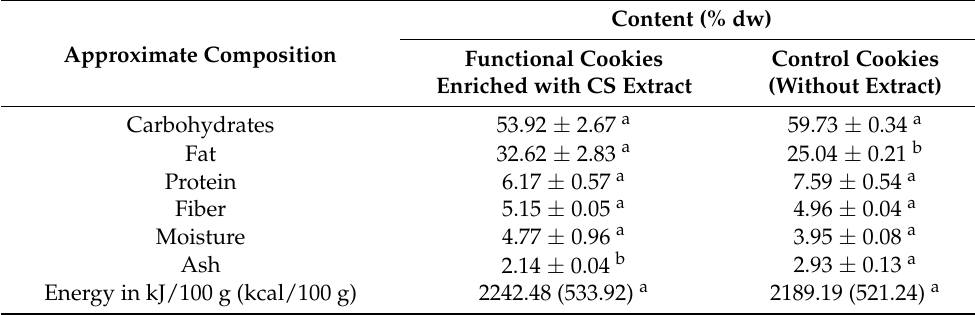
Table 2. Approximate composition (% dw) of functional cookies enriched with chestnut shells extract and control cookies (without extract). Approximate Composition